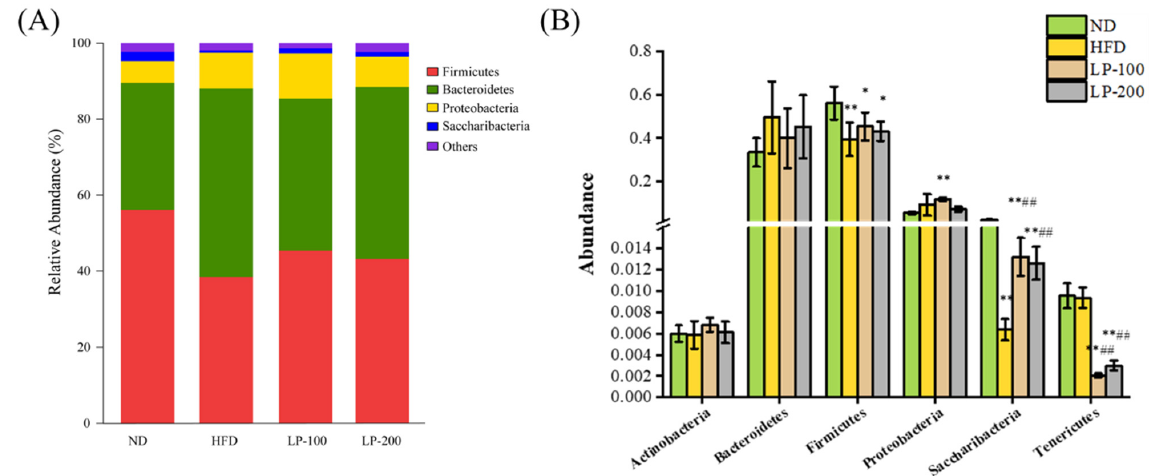
Figure 7. Comparison of histogram ( A ) and taxonomic differences in the bacterial species distribu- tion ( B ) at the phylum level of mouse intestinal bacteria. * p < 0.05, ** p < 0.01 compared with ND; ## p < 0.01 compared with HFD.